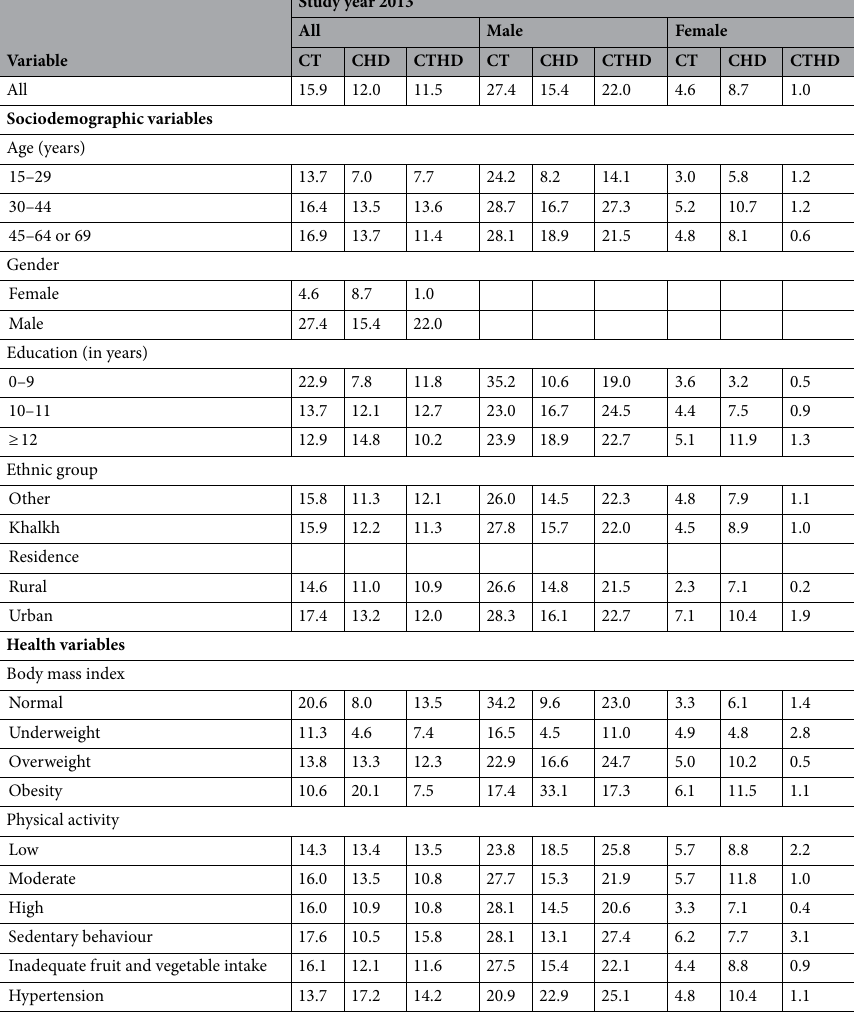
Table 5. Distribution in percent of prevalence of current tobacco use only (= CT), current heavy drinking only (= CHD), and current tobacco use and current heavy drinking (= CTHD) in the Mongolia STEPS survey,